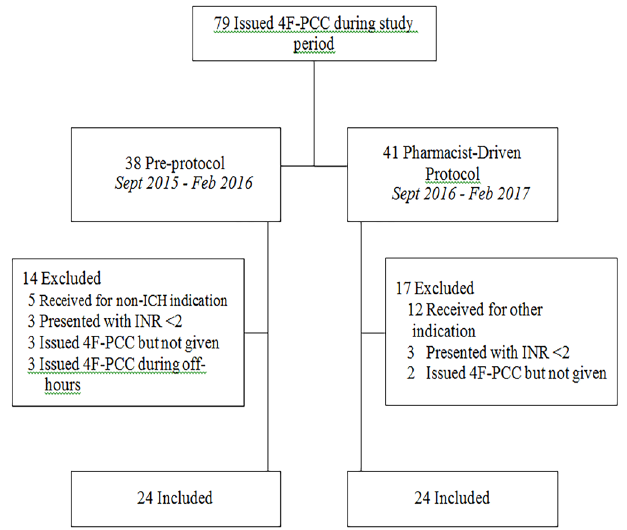
Figure. Inclusion and exclusion criteria. 4F-PCC, four-factor prothrombin complex concentrate; ICH , intra- cranial hemorrhage INR , international normalized